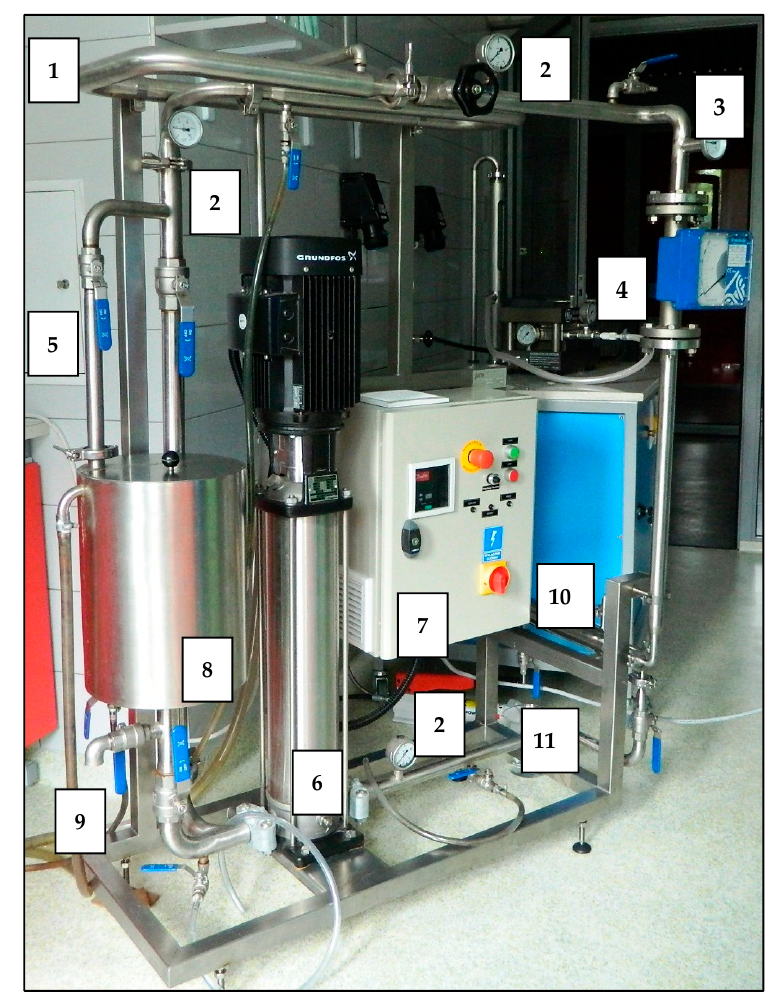
Figure 2. Picture of the first filtration system (1—water coat, 2—manometer, 3—thermometer, 4—flowmeter, 5—regulating valves, 6—high-pressure pump, 7—control box with inverter, 8—tank, 9—drain from the tank, 10—membrane module, 11—permeate outlet). Table 2. Characteristics of the membranes (manufacturer data).